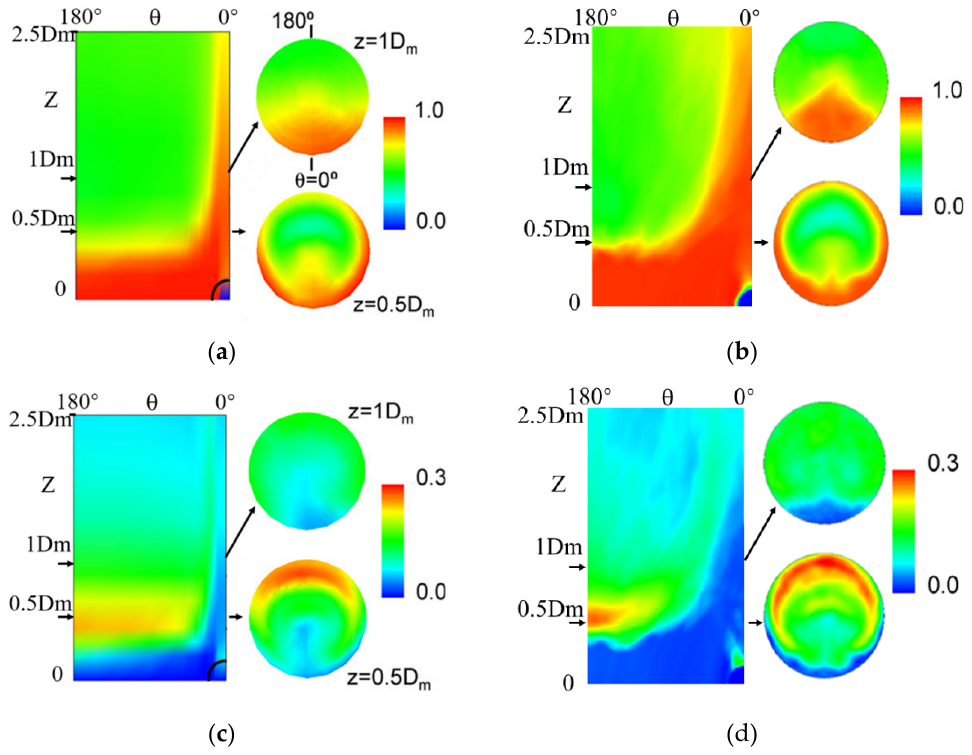
Figure 7. Temperature distribution downstream of D-ref case using LES and ELES: ( a ) Temperature T * distribution using LES; ( b ) Temperature T * distribution using ELES; ( c ) Temperature T sd* distri- bution using LES; ( d ) Temperature T sd* distribution using ELES.